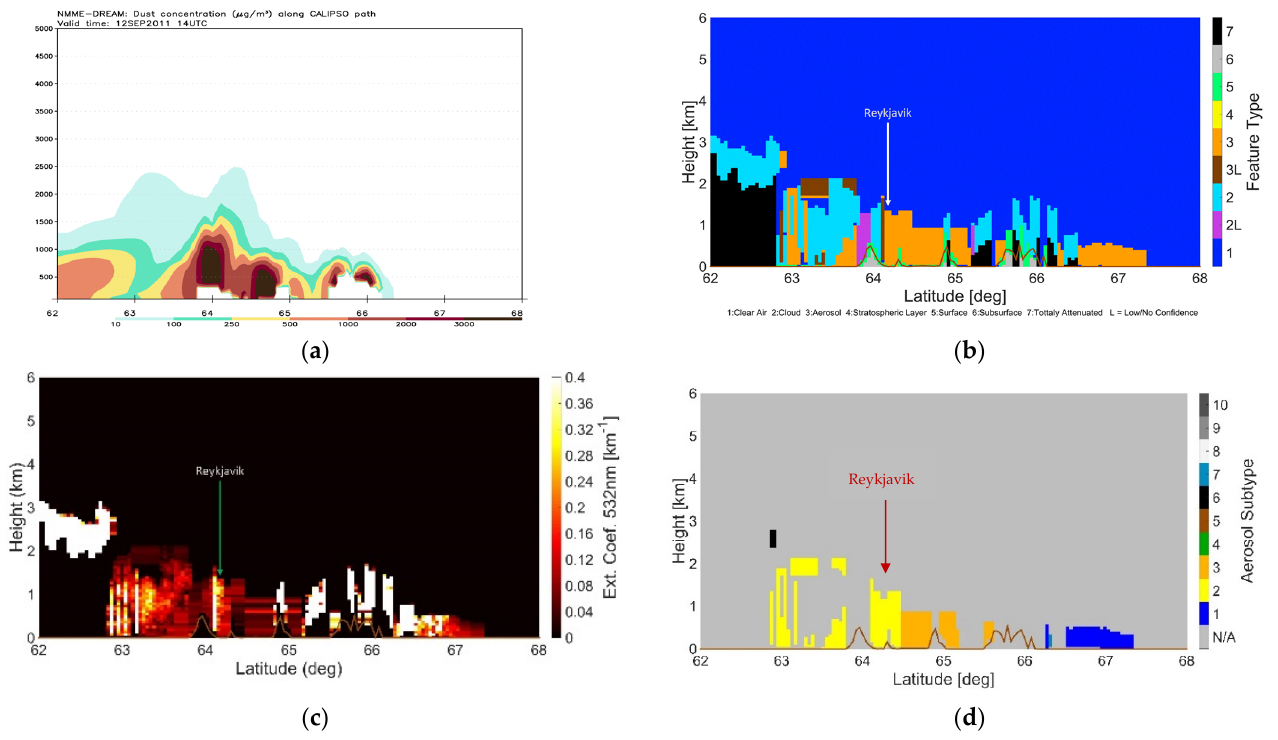
Figure 11. DREAM model and CALIPSO data along satellite path closest to the event, for 12 September 2011: ( a ) Model dust concentration; ( b ) CALIPSO vertical profile of recorded feature type with value 3 (aerosol) dominant at detected dust plume region; ( c ) CALIPSO extinction coefficient that marks detection of the pure dust near Reykjavik; and ( d ) CALIPSO aerosol subtypes: 1—ma-